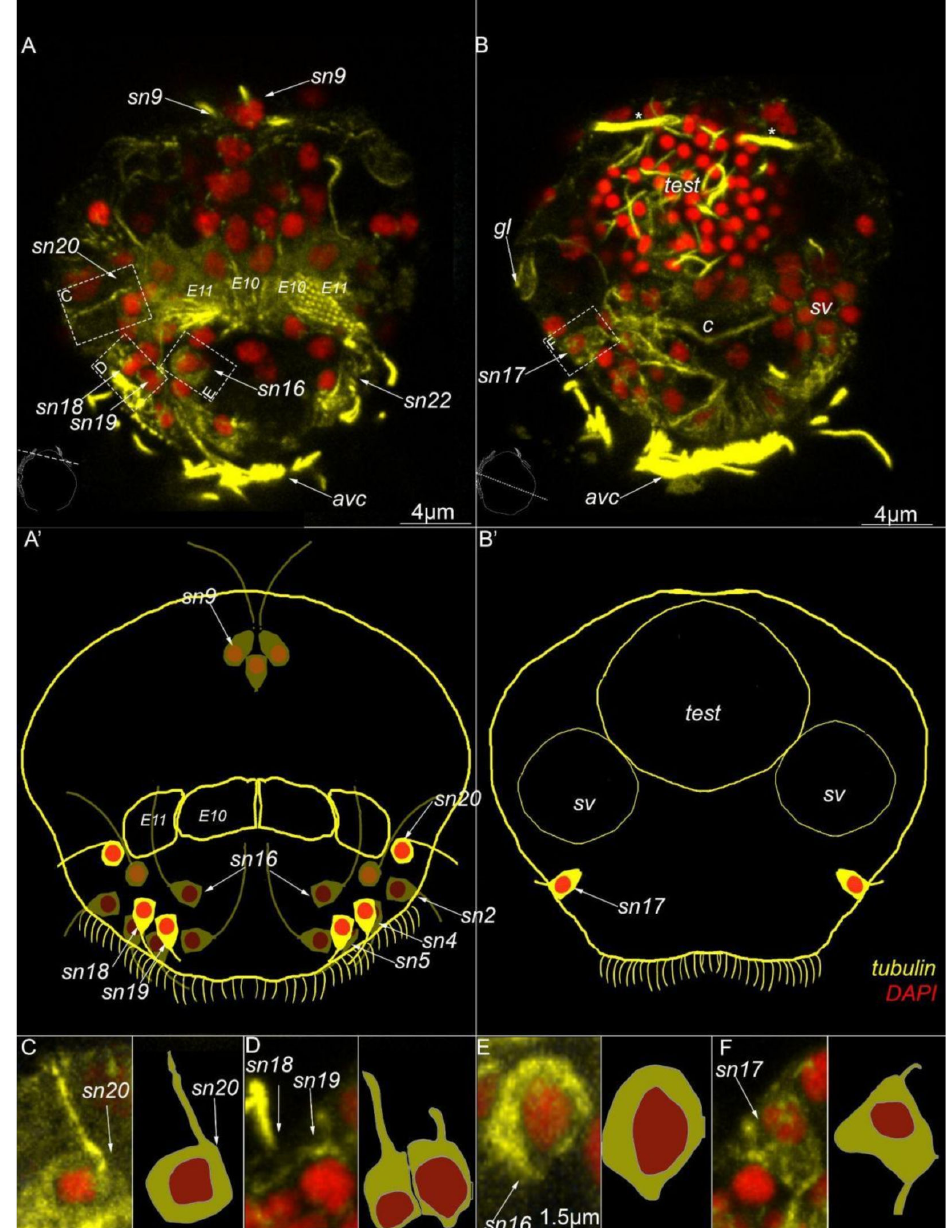
Figure 8. Type 2 sensory neurons in mature Dimorphilus gyrociliatus dwarf male revealed by anti- acetylated alpha-tubulin labeling. ( A ) Anterior surface view. ( A (cid:48) ) Schematic representation of the anterior surface. ( B ) The posterior surface view. ( B (cid:48) ) Schematic representation of the posterior surface view. ( C ) The close-up and drawing of sensory neuron № 20. ( D ) Close-up and drawing of sensory neurons № 18 and 19. ( E ) The close-up of sensory neuron № 16. ( F ) The close-up of sensory neuron № 17. Abbreviations: E10, 11 —multiciliated cells of the dorsal ciliary field; dc —dorsal cilia; pvc —posterior cilia; sgd —stylet gland cell; sn1–sn20 —sensory neurons